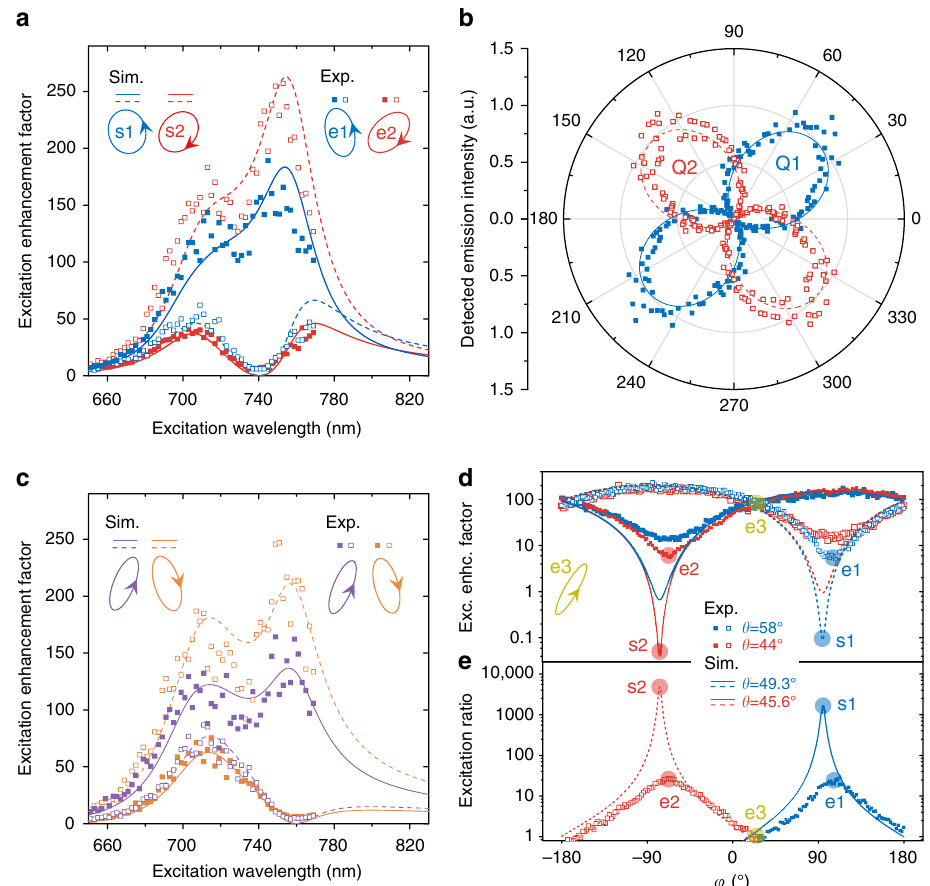
Fig. 3 Experimental demonstration of selective far- fi eld excitation and detection with both Q1 and Q2 in the nanosystem. a Excitation enhancement spectra for Q1 (solid data points; in order to measure for Q1, Q1 is selectively detected) and Q2 (hollowed data points; in order to measure for Q2, Q2 is selectively detected) when excited with elliptical polarizations for optimal selective excitation of Q1 (blue data points; elliptical polarization e1) or Q2 (red data points; elliptical polarization e2) at 740 nm wavelength. Solid (dashed) curves are simulated excitation enhancement spectra for Q1 (Q2). b Polar plot of the emission polarization measurement when Q1 (blue solid data points) is selectively excited (using elliptical polarization e1) or when Q2 (red hollowed data points) is selectively excited (using elliptical polarization e2). The solid and dashed curves are simulated results. c Same as a but with excitation polarizations optimized at 760 nm wavelength. d Excitation enhancement factor at 740 nm wavelength as a function of φ (at two fi xed θ values). Solid data points (experiment) and solid curves (simulation) are for Q1, while hollowed data points (experiment) and dashed curves (simulation) are for Q2. e Excitation ratio at 740 nm wavelength as a function of φ (at two fi xed θ values). Solid data points (experiment) and solid curves (simulation) are the = σ excitation ratio σ , while hollowed data points (experiment) and dashed curves (simulation) are the excitation ratio σ Q1 Q2 d and e indicate the polarizations for optimal selective excitation of Q1 (Q2) shown in a . The yellow-green circles indicate the polarization e3 (inset at the left of d ) to equally excite Q1 and